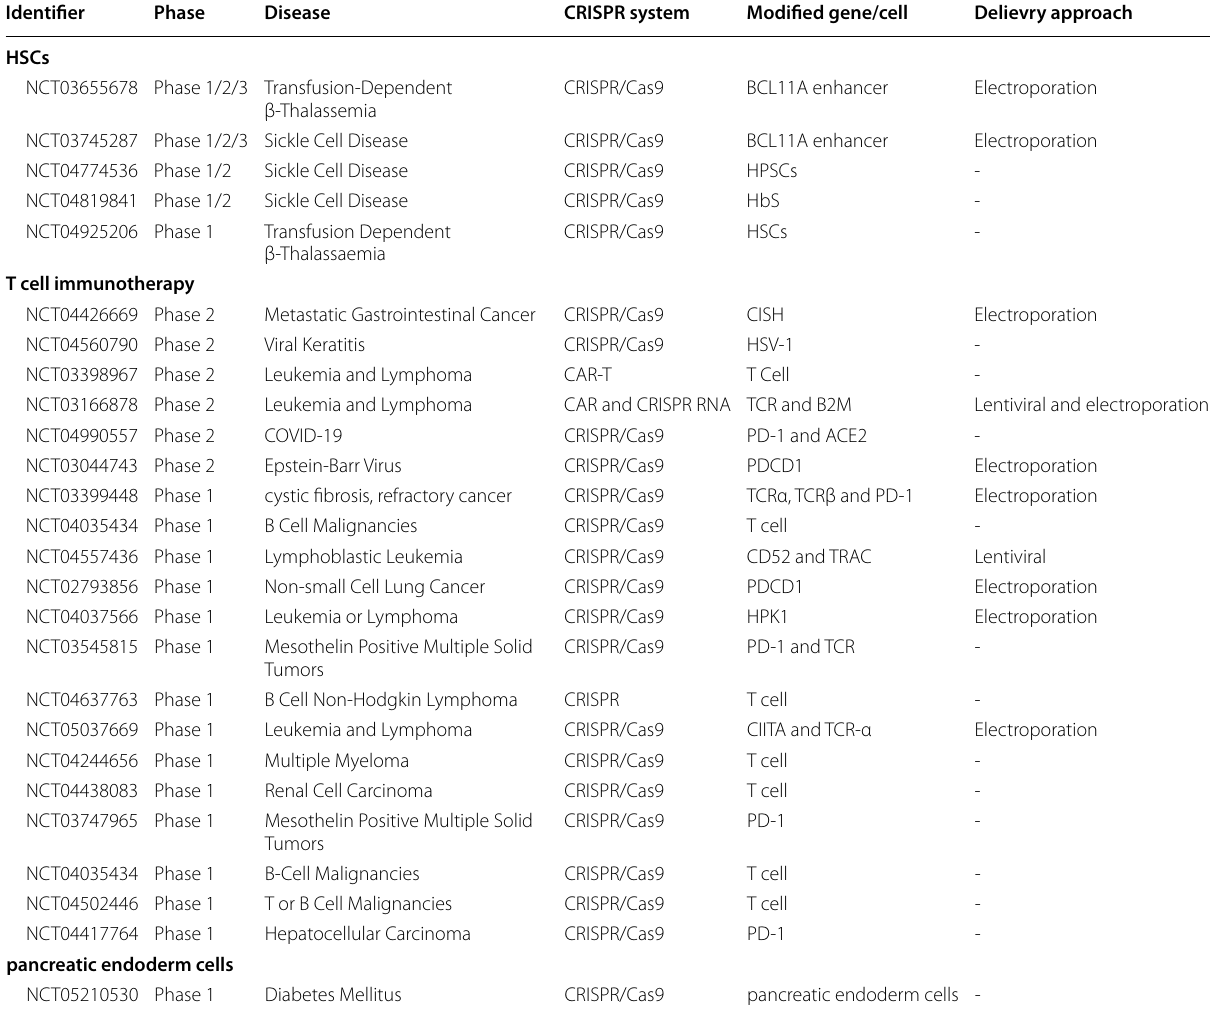
¶ Data were obtained from ClinicalTrials.gov and